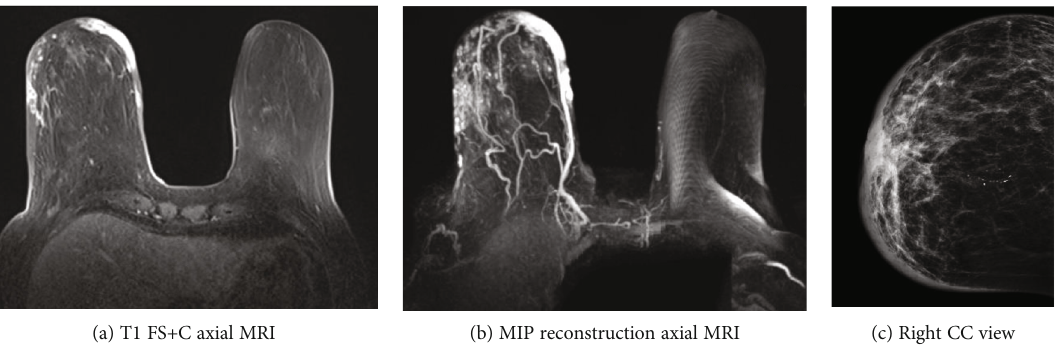
Figure 6: (a – c) This is a di ff erent case. An 80-year-old patient with remote history of right breast lumpectomy and radiation treatment due to breast malignancy. Patient presented with similar clinical symptoms of skin changes and discoloration. Axial T1 with fat suppression (FS), postcontrast injection (+C) MRI (Figure 6(a)), and MIP reconstruction (Figure 6(b)) demonstrating marked skin thickening and enhancement. Corresponding right CC mammographic view (Figure 6(c)) demonstrating marked skin thickening with no discreet mass within the